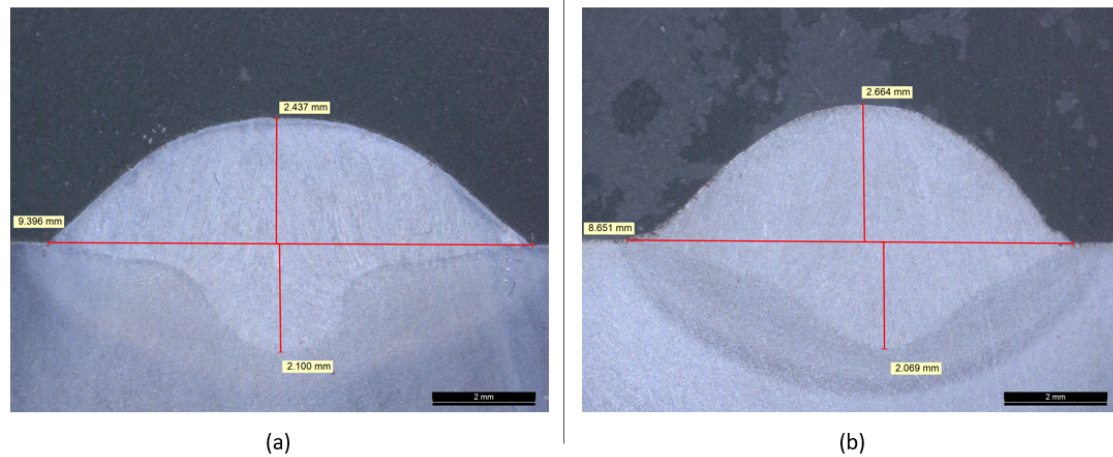
Figure 11. Cross-sections of the ( a ) CMT sample and ( b ) MIG sample showing distinctive shapes of the penetration area for each processing mode at higher heat inputs.